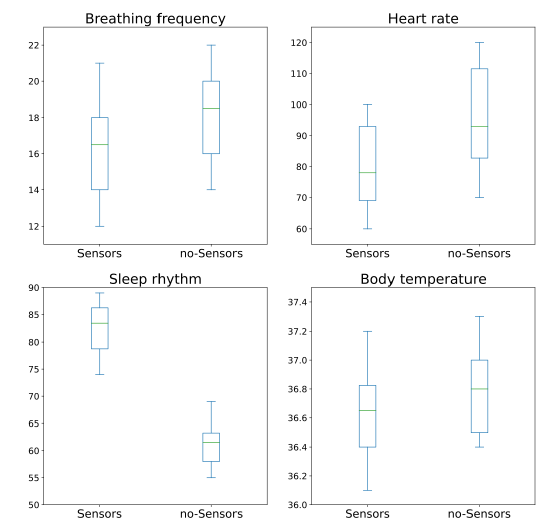
Figure 10. Box plots for “sensor” and “no-sensor” categories for all